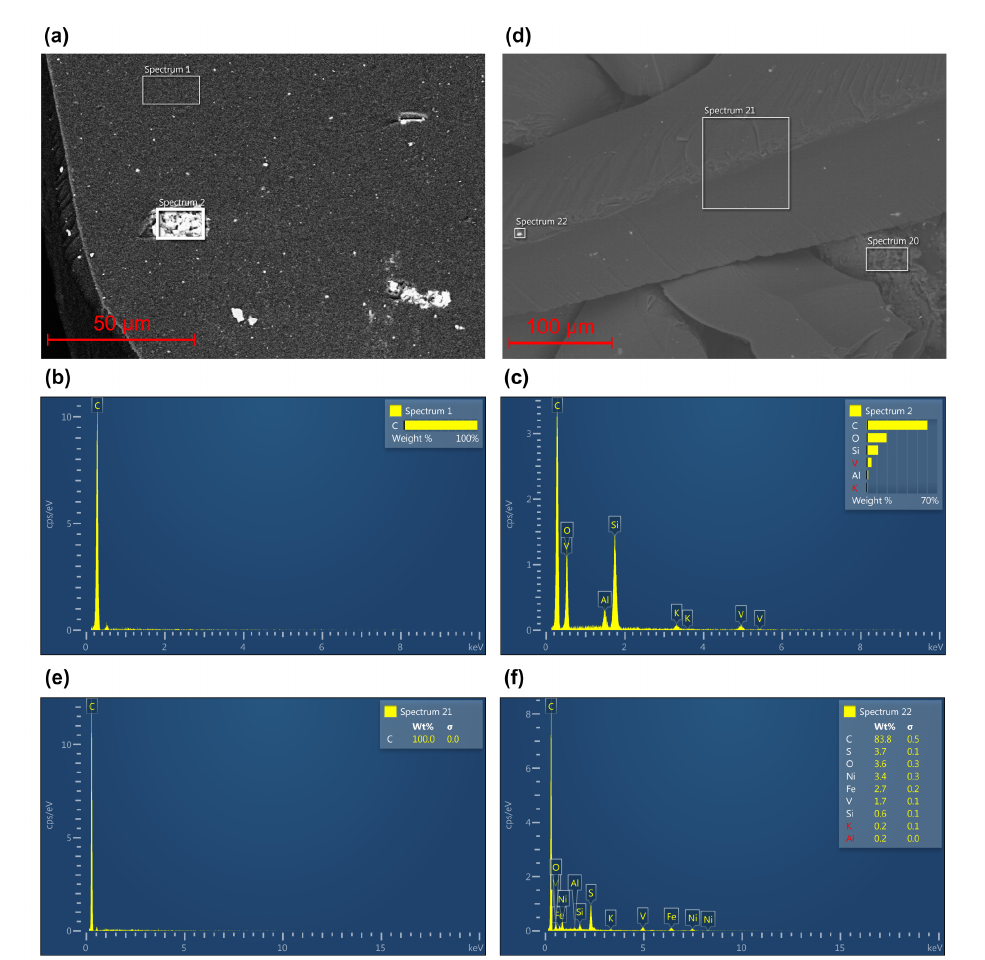
Figure 3. Scanning electron microscopy with EDS image of shungite particles: ( a ) first-selected sample study areas, ( b ) chemical composition of area spectrum 1, ( c ) chemical composition of area spectrum 2, ( d ) second-selected sample study areas, ( e ) chemical composition of area spectrum 21 and ( f ) chemical composition of area spectrum